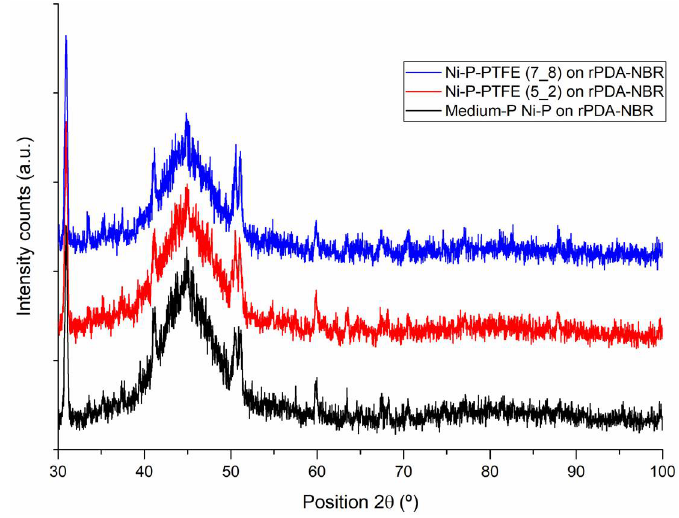
Figure 4. XRD analysis of Ni-P, Ni-P-PTFE (5_2) and Ni-P-PTFE (7_8) films.